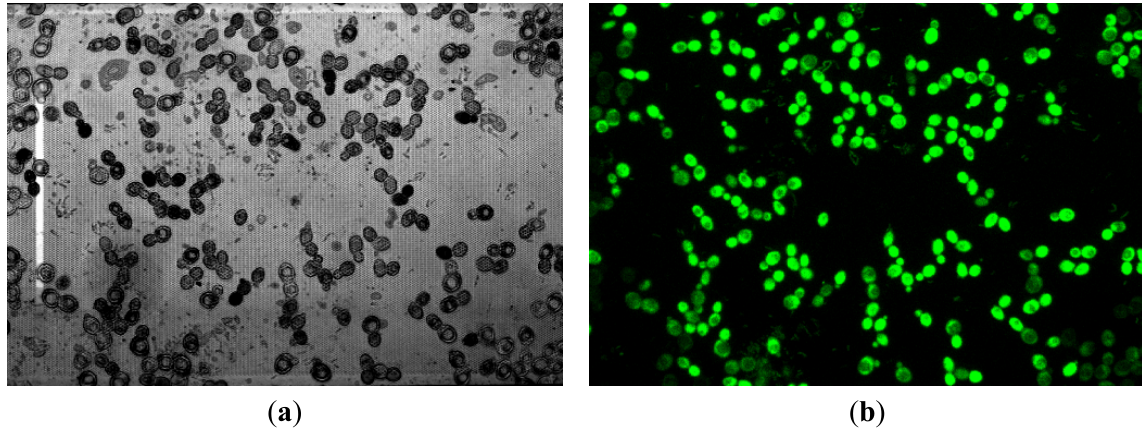
Figure 13. CLSM image in reflection and ( a ) fluorescence ( b ) mode in of a 0.45 µm microsieve fouled by S. cerevisiae suspension dyed by rhodamine 123 and fluorescein diacetate.